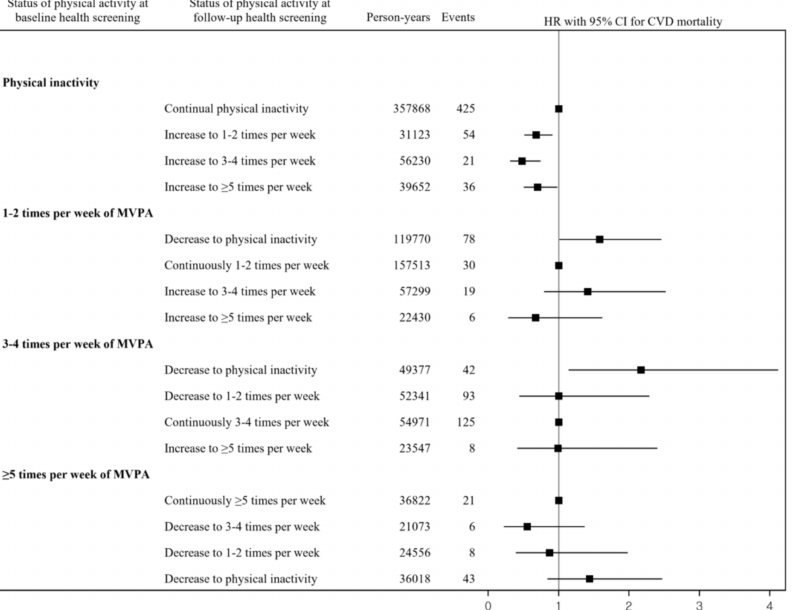
Figure 3. Relationship between changes in the frequency of MVPA and the subsequent risks of CVD mortality. Note. HR, hazard ratio; CI, confidence interval; MVPA, moderate to vigorous physical activity; CVD, cardiovascular disease. HRs and 95% CIs were estimated after adjusting for sex, age, body mass index, systolic blood pressure, diastolic blood pressure, serum glucose, total cholesterol, alcohol consumption, cigarette smoking status, household income, location of residence, disability, and